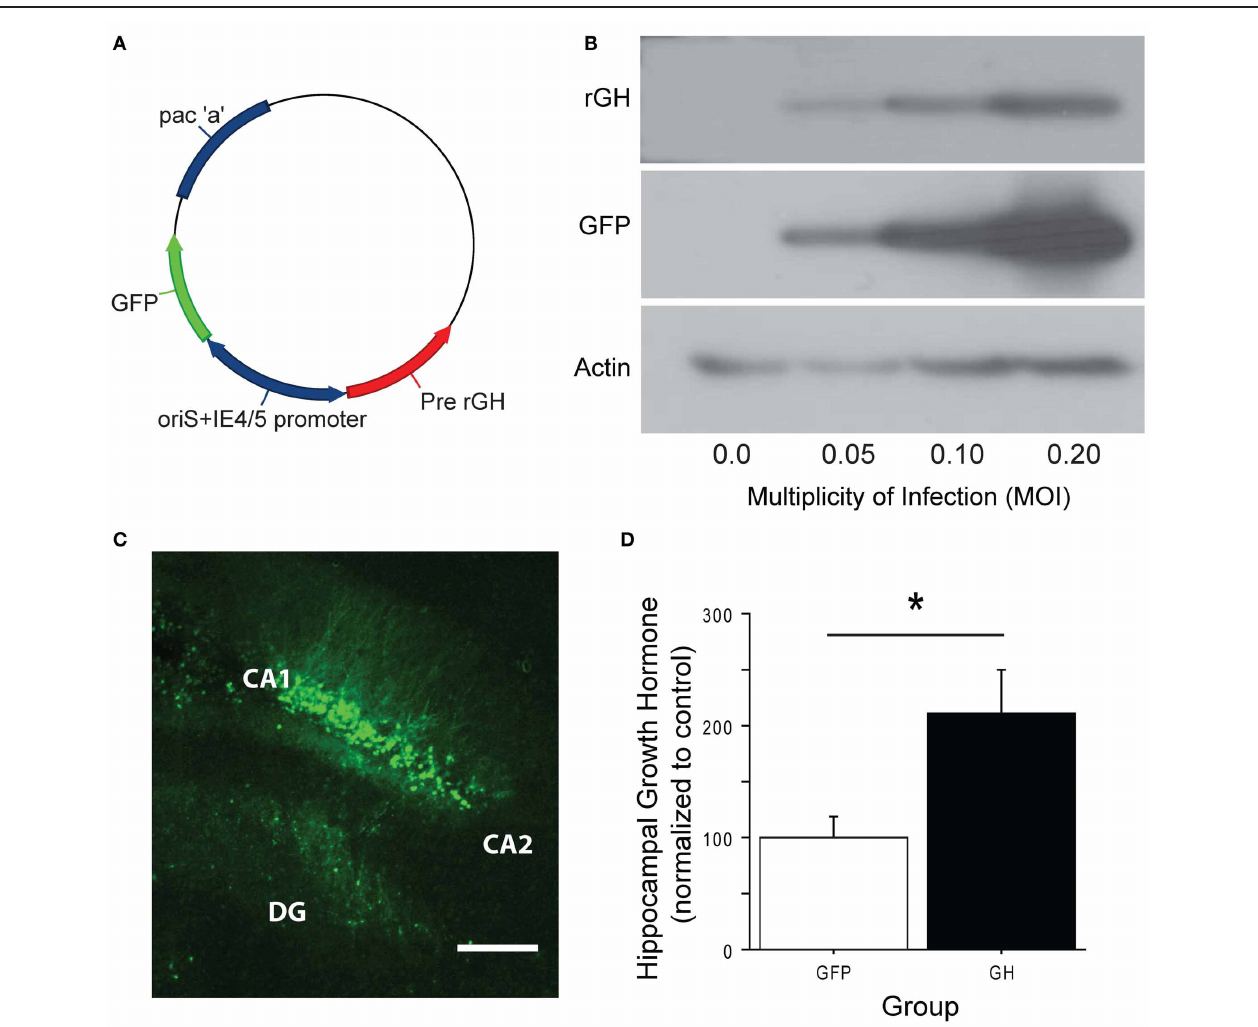
FIGURE 2 | Construction of an HSV-1 viral vector to overexpress GH. (A) The full-length gene for presomatotropin was cloned into an HSV-1 amplicon under the control of the HSV α -4 promoter. eGFP was co-expressed via the HSV α -22 promoter. (B) GH protein expression was confirmed in vitro . Vero cells were infected with GH virus at increasing MOIs. As the MOI increased, progressively higher levels of both GH and eGFP were detected. (C) The viral vector was infused into the dorsal hippocampus of rats. A